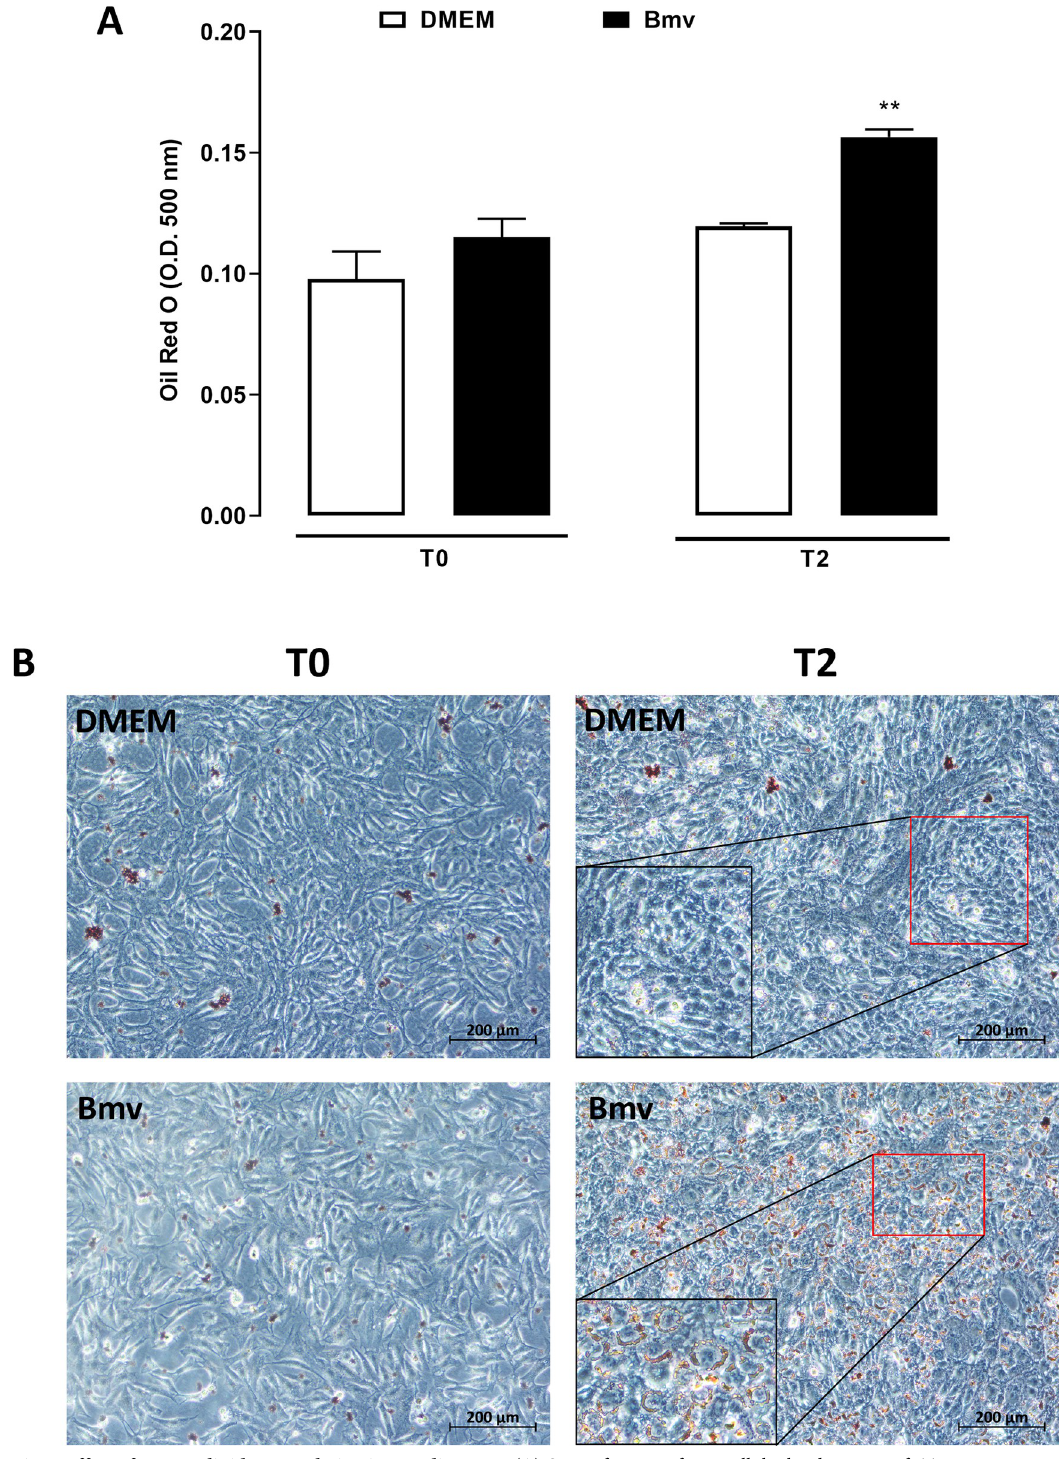
Fig 8. Effect of Bmv on lipid accumulation in preadipocytes. (A) Quantification of intracellular lipid content of 3T3-L1 preadipocytes subjected to differentiation medium with or without stimulation by Bmv (1 μ g /mL). 24 h after stimulation, the culture medium of all groups was changed to a fresh differentiation medium, without Bmv, and maintained for 24 h. Cells were then fixed and stained with Oil Red O as described in Material and Methods. Results are expressed as mean + S.E.M. (n = 4). �� p < 0.01 vs. DMEM (ANOVA and Bonferroni post test); (B) Photomicrographs of cell cultures at different experimental times and